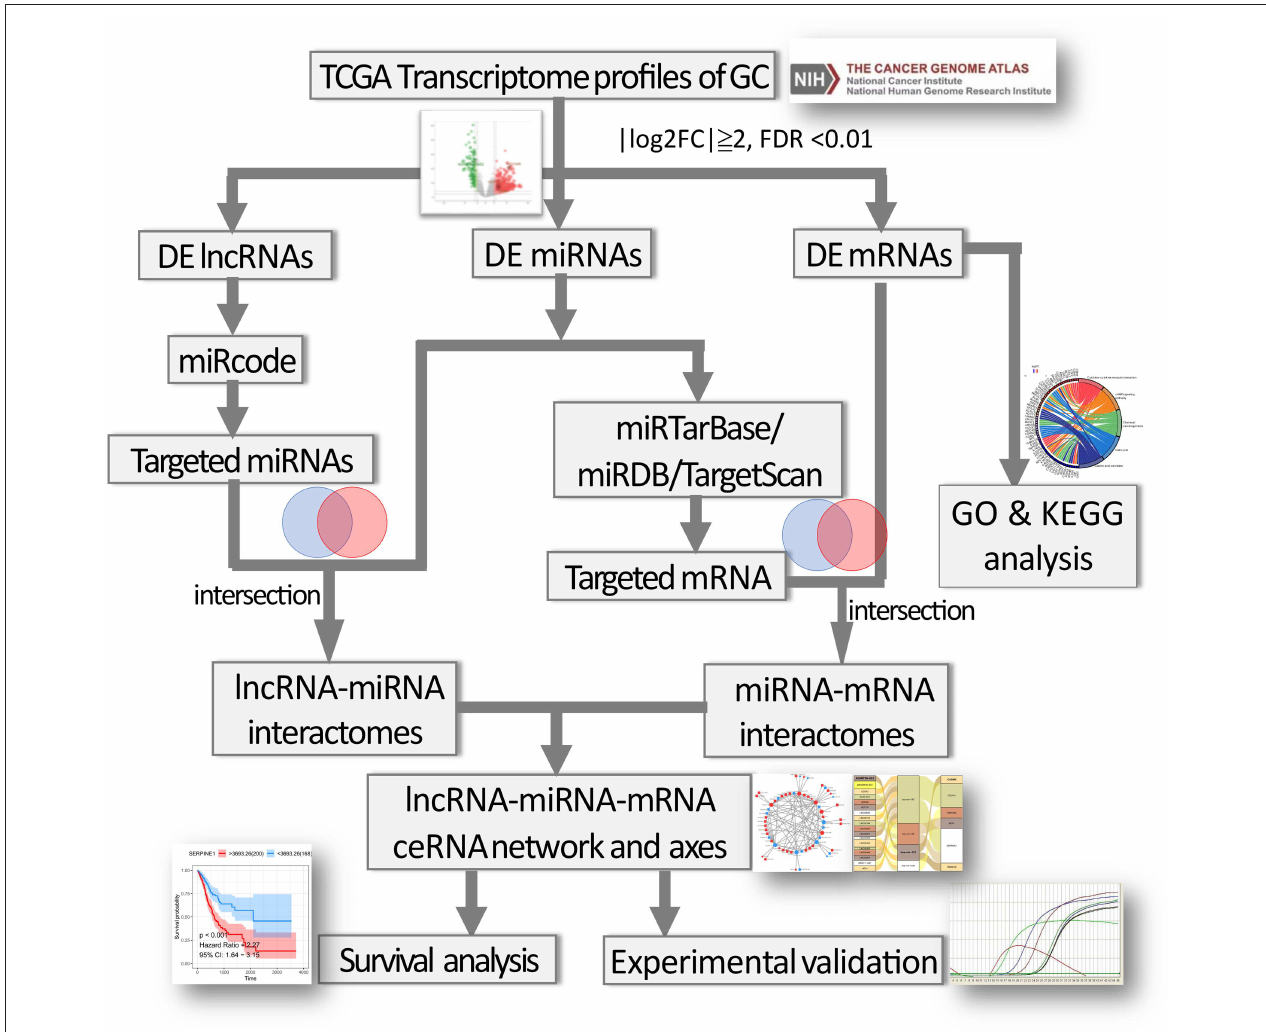
FIGURE 1 | Flow chart of the construction of ceRNA network and regulatory axes in gastric cancer.